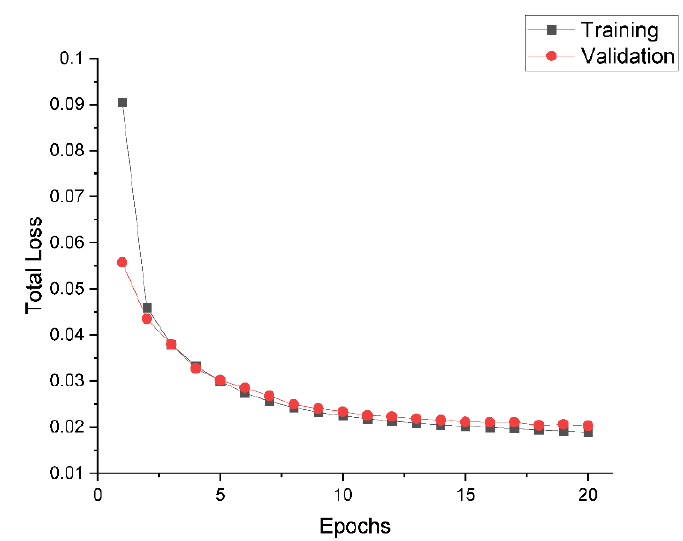
Figure 7. Total losses (training vs. validation) over 20 epochs for the SAPC2 model.